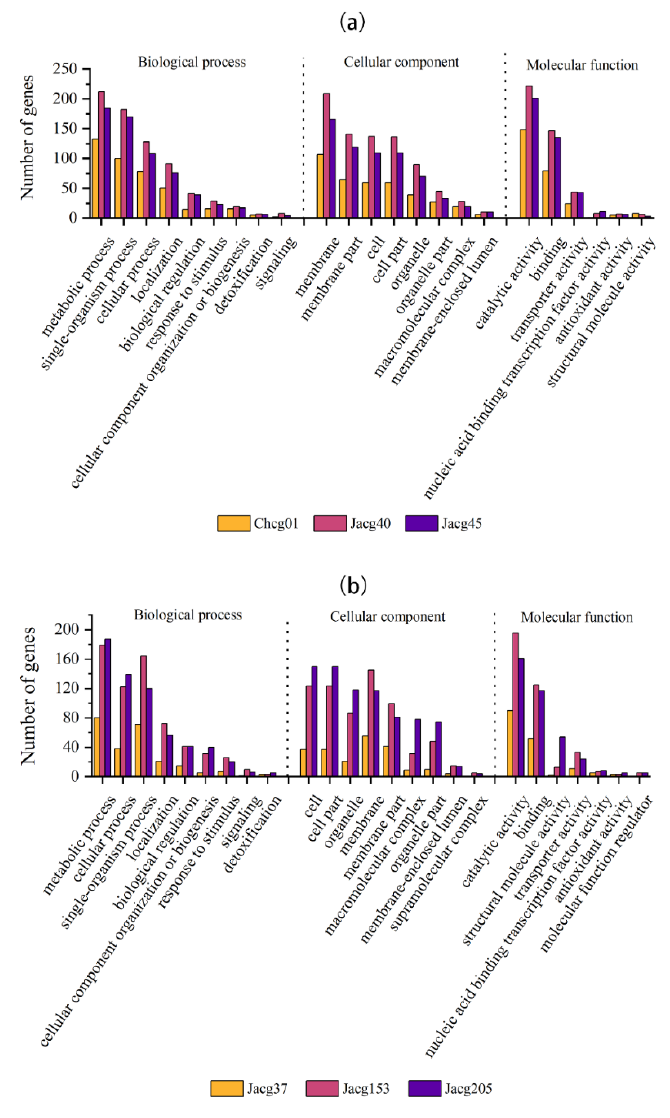
Figure 6. Gene ontology (GO) enrichment analysis of the DEGs in six strains of Cenococcum geophilum after 10% PEG-6000 treatment compared to the control treatment (0% PEG-6000). ( a ) three drought- sensitive strains (Chcg01, Jacg40, and Jacg45); ( b ) three drought-tolerant strains (Jacg37, Jacg153, and Jacg205). The abscissa is the GO classification and the ordinate is the number of genes.